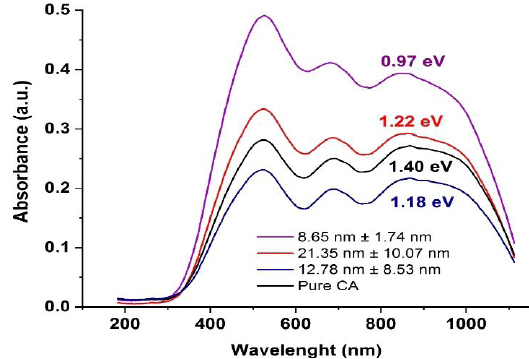
Figure 2. UV-VIS absorption spectra of the synthesized electrodes and pure carbon aerogel.